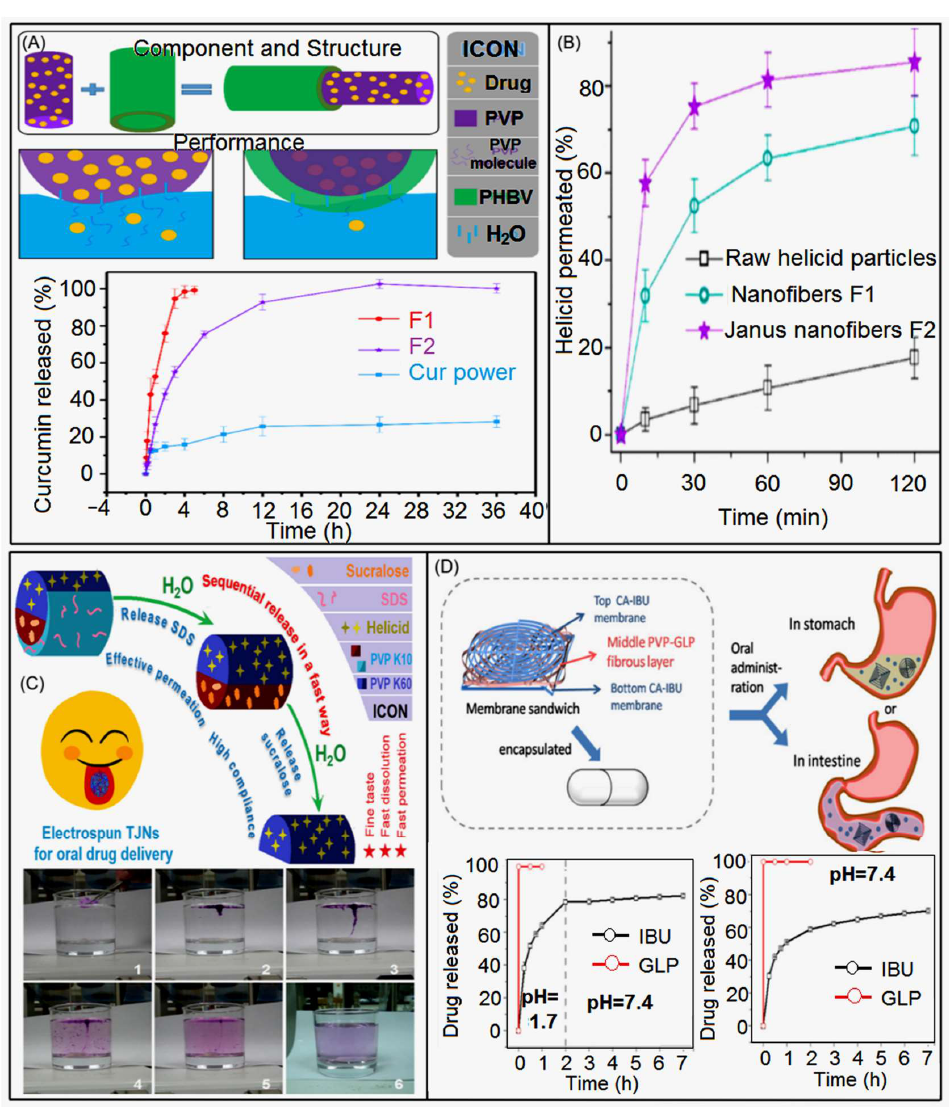
Figure 11. Nanofiber herbal medicine delivery system. ( A ) Drug release mechanism ( the up section ) and curcumin release curve of core-sheath structure nanofibers ( the down section ), reprinted with permission from [136] copyright 2022, Polymers. ( B ) Membrane permeability of Helicid, reprinted with permission from [63] copyright 2018, American Chemical Society. ( C ) Release mechanism of three-fluid hydrophilic Janus structure and rapid disintegration experiment of fiber membrane, reprinted with permission from [204] copyright 2022, Springer Nature; ( D ) Hydrodynamic EHD printing combined with electrospinning technology, the dissolution and release mechanism of fiber membrane in gastric juice and intestinal juice, reprinted with permission from [175] copyright 2018, American Chemical Society.